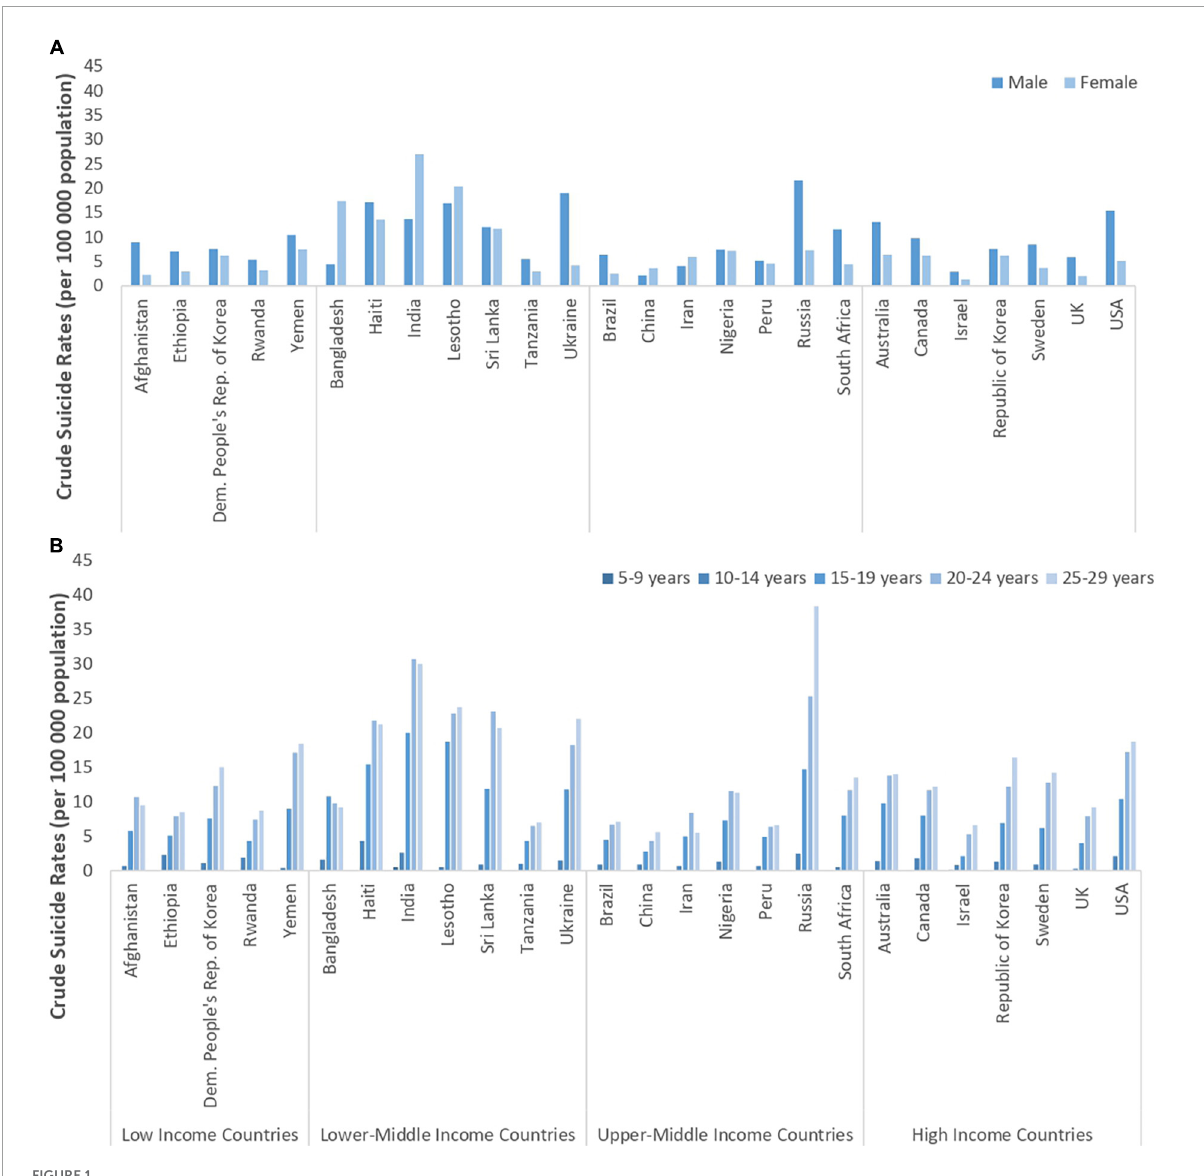
FIGURE1 Source data: World Health Organization Global Health Observatory data repository (http://apps.who.int/gho/data/node.main.MHSUICIDE5YEAR AGEGROUPS?lang=en, 1a, 1b; http://apps.who.int/gho/data/node.main.MHSUICIDEAGEGROUPS15293049?lang=en, 1c) 2016 data; accessed October 24, 2019. (A) Crude suicide rates among 15–19 year-old children, by sex. Sex differences in the 15–19 age category vary between countries within across income categories. (B) Crude suicide rates among individuals 5–29 years, both sexes, by 5-year intervals. Suicide rates are consistently lowest in the 5–9 age range and increase through to age 24, but are heterogeneous around the